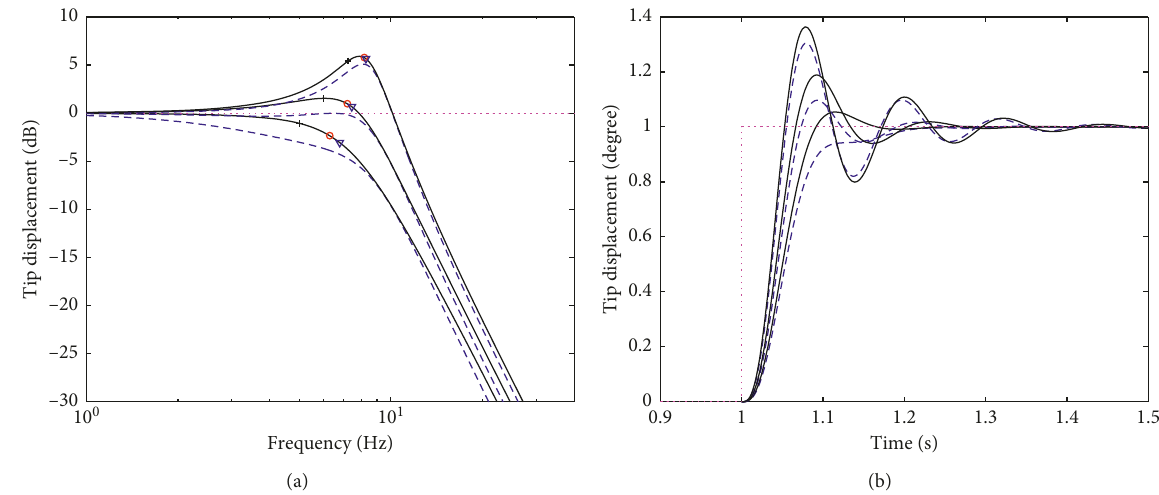
Figure 7: Predicted tip displacements: (a) the frequency responses from Equation (12) (dashed lines) and Equation (13) (solid) for three test 0 . 3 (upper pair), 0 . 5 (middle), and 1/ cases: η e (cid:31) ω n , the standard natural frequency ω s , and the damped natural frequency ω d in successive order. The dotted line indicates the command (cid:31) input signal. (b) The corresponding time responses to a step